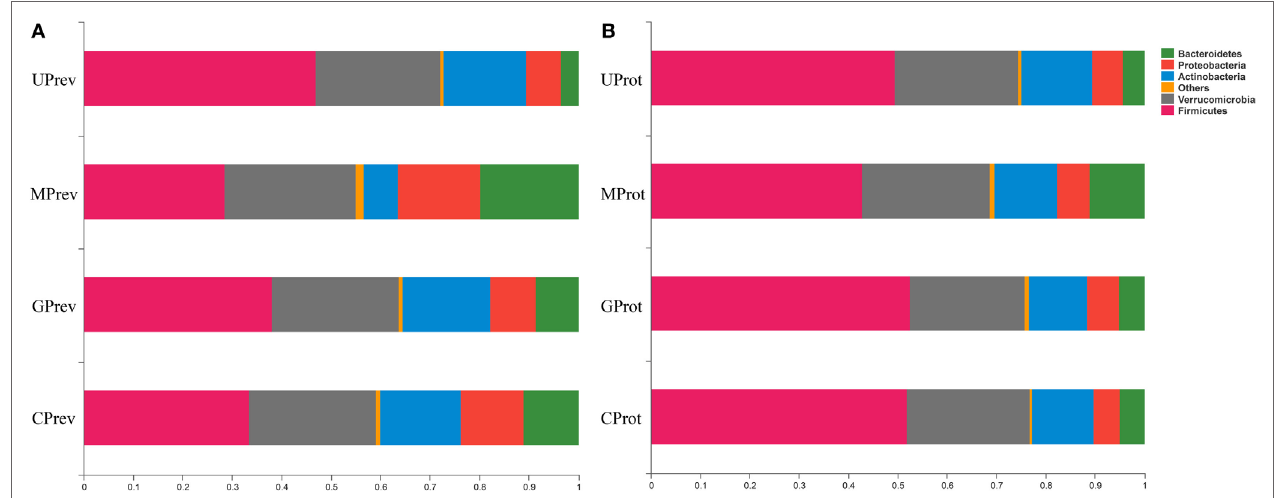
FigUre 5 | Relative abundance of different phyla in the gut microbiota of mice from the eight treatment groups: (a) samples taken 1 day after administration of CCl 4 (to determine preventive effects of milk consumption on induced liver injury) from: untreated control mice (UPrev), model mice (MPrev), mice receiving goats’ milk (GPrev), and mice receiving cows’ milk (CPrev) and (B) samples taken 8 days after administration of CCl 4 (to determine protective effects of continued milk consumption on induced liver injury) from untreated control mice (UProt), model mice (MProt), mice receiving goats’ milk (GProt), and mice receiving cows’ milk